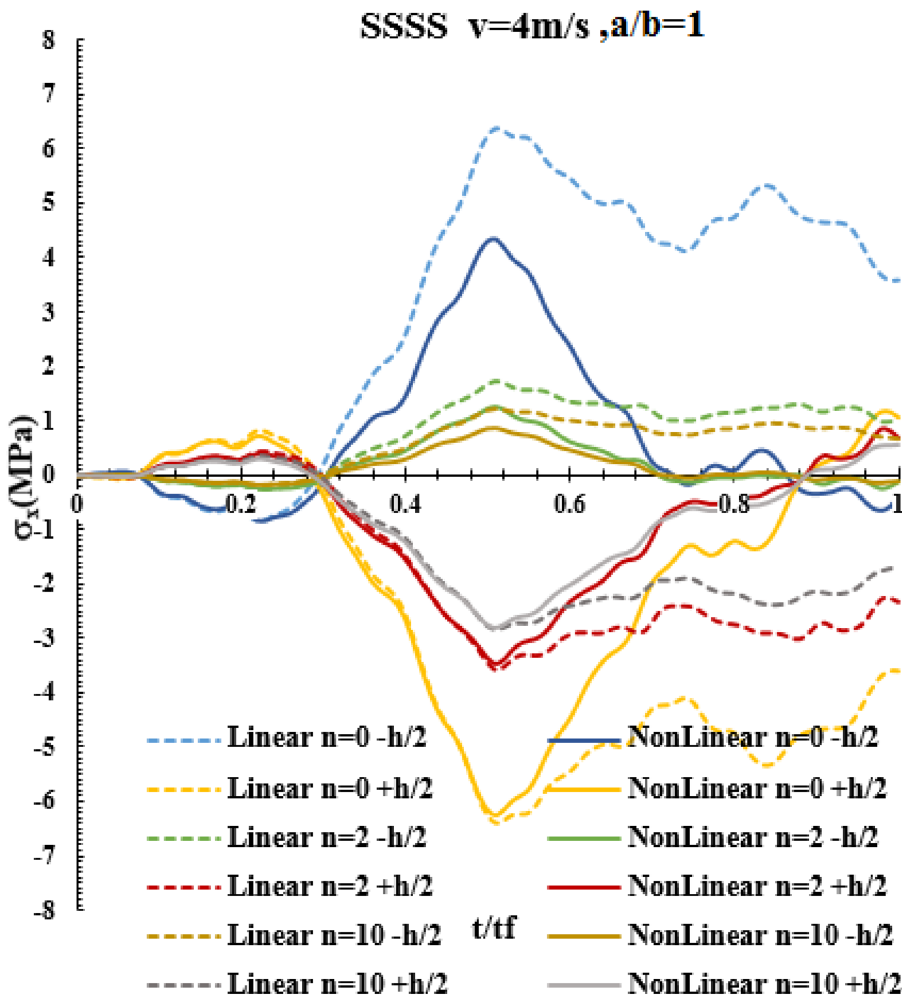
Fig. 21 The effect of material gradient index on transient dis- tribution of 𝜎 xx for center-point of the plate (SSSS, v = 1